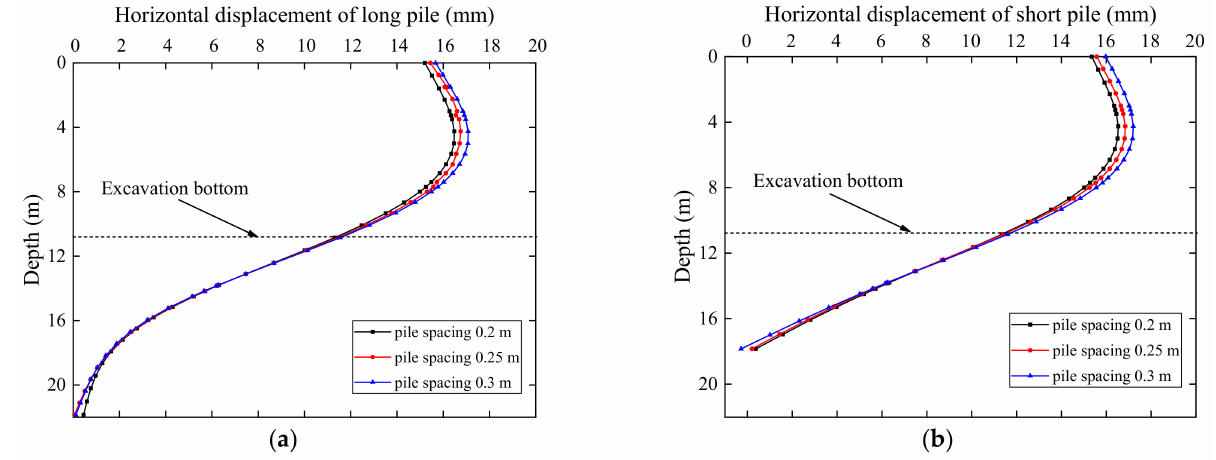
Figure 19. Horizontal displacement of long and short piles with different spacing: ( a ) long pile; ( b ) short pile.